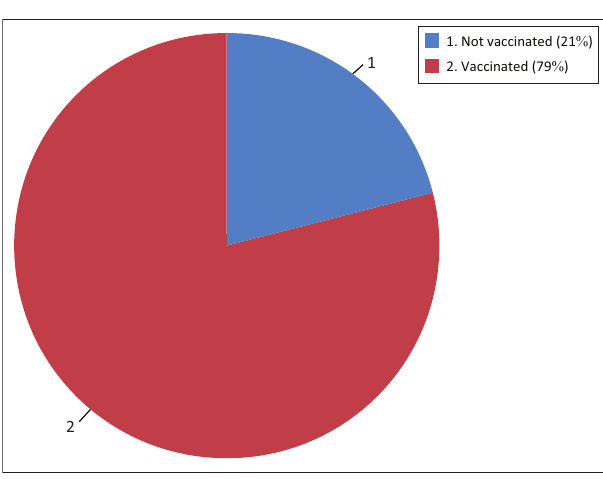
FIGURE 1: Percentage of healthcare workers who received at least one dose of hepatitis B virus vaccine ( n = 460).